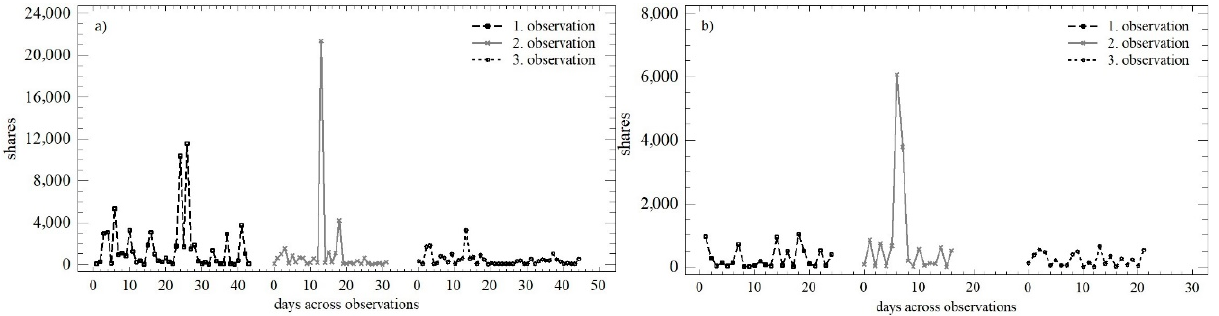
Figure 8. Scatterplot of the numbers of shares in the observation periods: ( a ) working days; ( b )